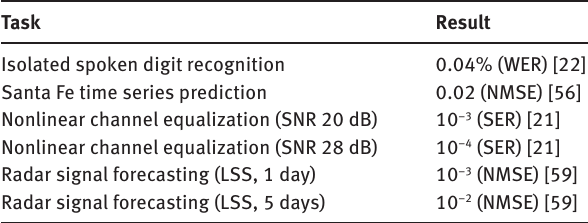
Table 1: Summary of the best reported results obtained by the opto- electronic reservoir computer for computationally hard